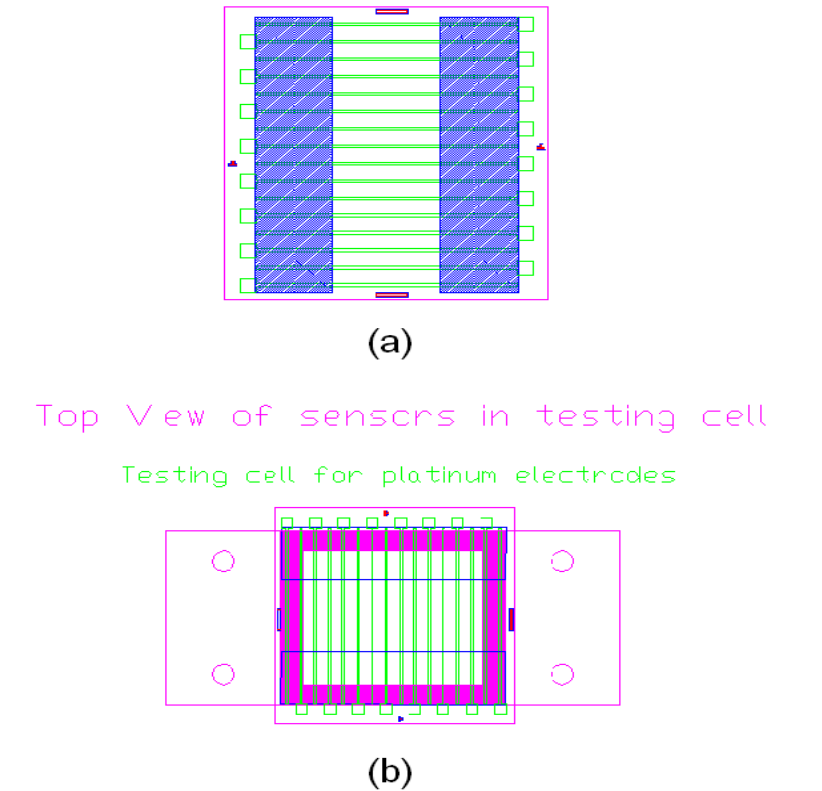
Figure 1. Schematic of sensor structure and layout (a): schematic diagram of the design of conductivity sensor: parallel platinum electrodes (green) sealed by Al (blue); (b): schematic diagram of sensor chip and testing cell